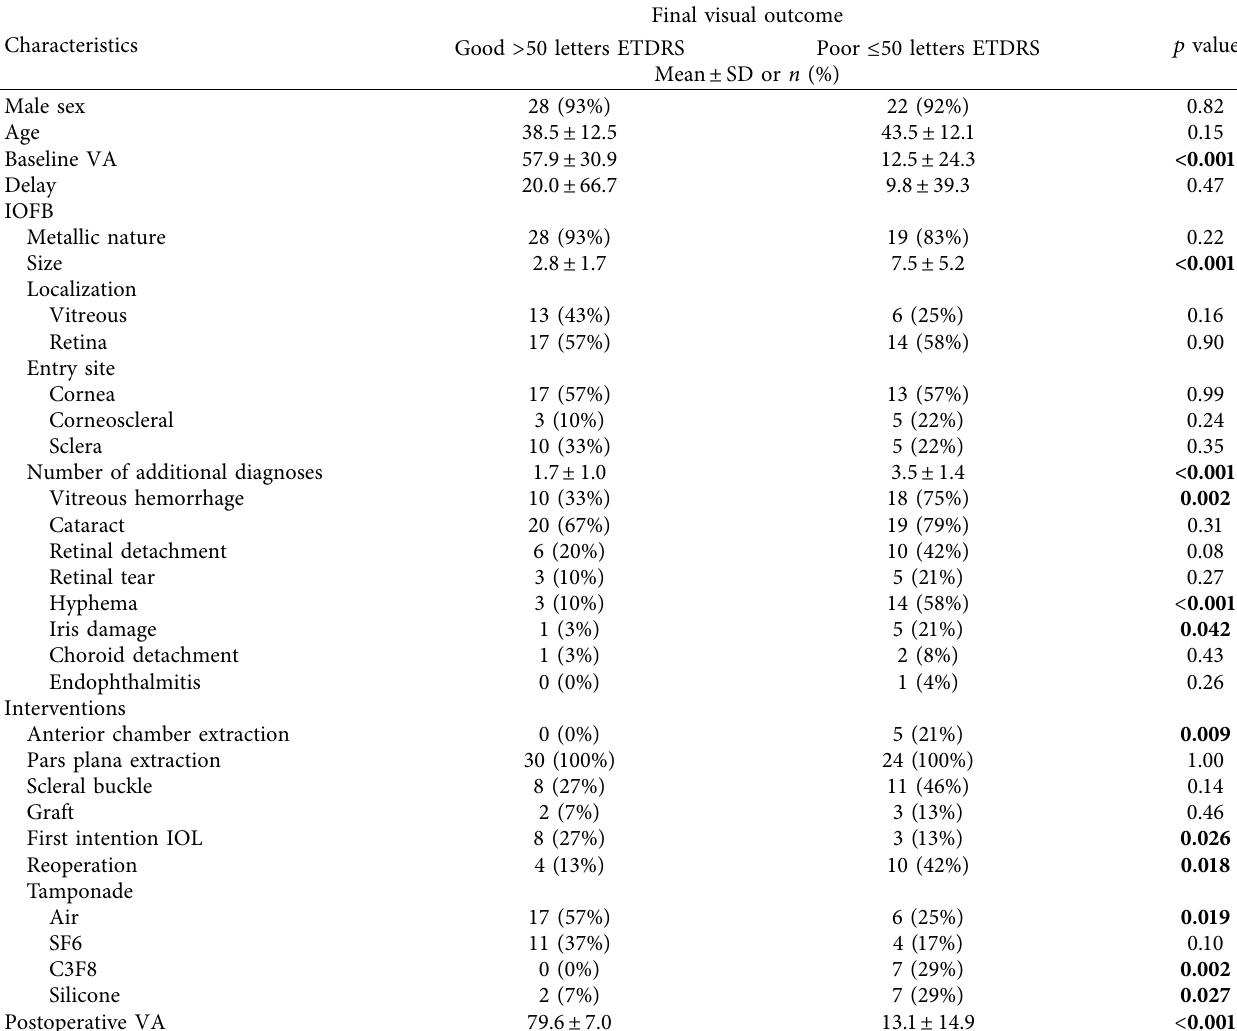
Table 3: Baseline characteristics of 54 patients with intraocular foreign body by final visual acuity.